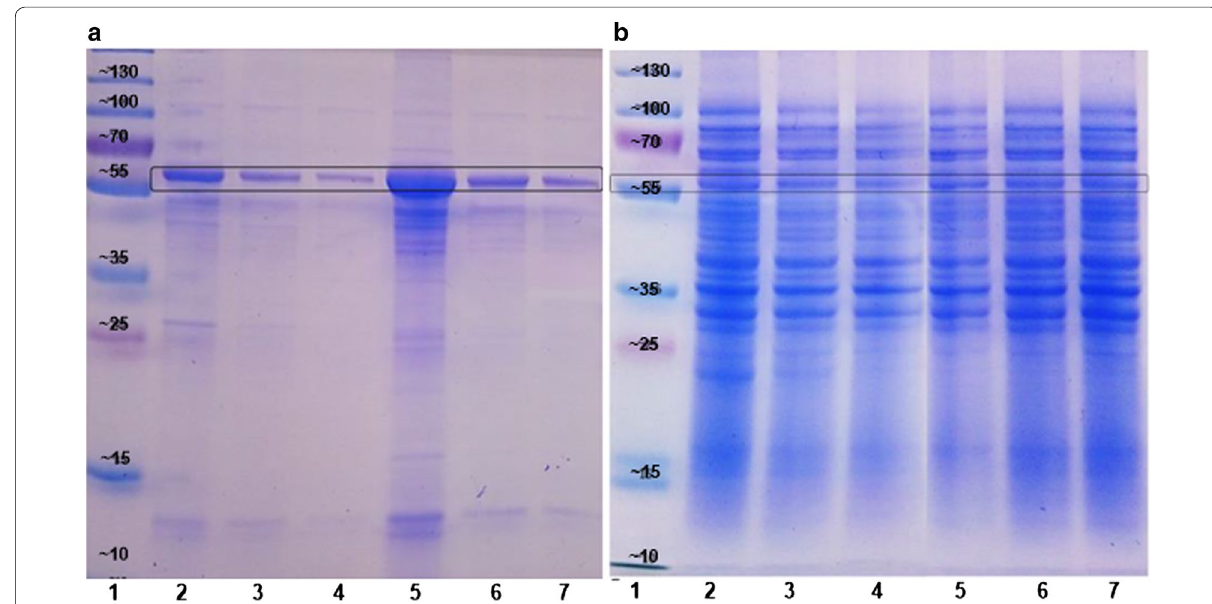
Fig. 3 SDS-PAGE of E. coli BL21DE3 cultures hosting d -Hyd and d -Hyd(co) after cultivation and expression under oxygen deficiency. a Qualitative analysis of the insoluble fraction, 1 protein standard with molecular weights in kDa, 2 d -Hyd at 120 rpm, 3 d -Hyd at 100 rpm, 4 d -Hyd at 90 rpm, 5 d -Hyd(co) at 120 rpm, 6 d -Hyd(co) at 100 rpm, 7 d -Hyd(co) at 90 rpm. b Qualitative analysis of the soluble fraction, 1 protein standard with molecular weights in kDa, 2 d -Hyd at 120 rpm, 3 d -Hyd at 100 rpm, 4 d -Hyd at 90 rpm, 5 d -Hyd(co) at 120 rpm, 6 d -Hyd(co) at 100 rpm, 7 d -Hyd(co) at 90